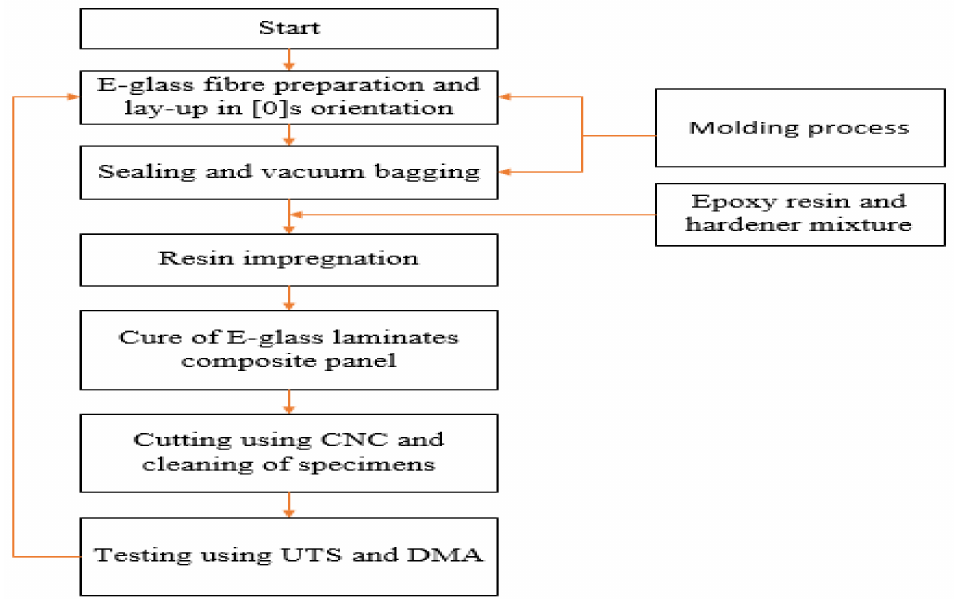
Figure 1. Flow chart of specimen preparation using the RTM